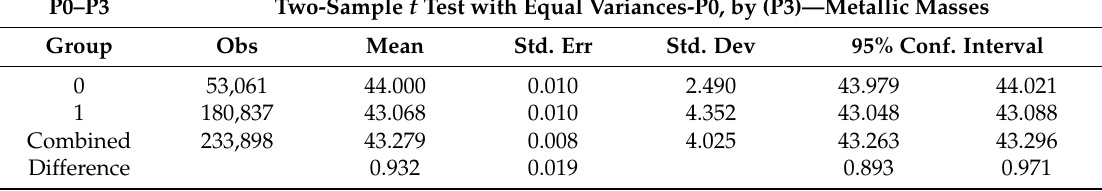
Table 5. Results: P0 by P3: Variability 932 nT between 0 and 1 with p -value: 0.004. Table 5 . Results: P0 by P3: Variability 932 nT between 0 and 1 with p -value: 0.004.